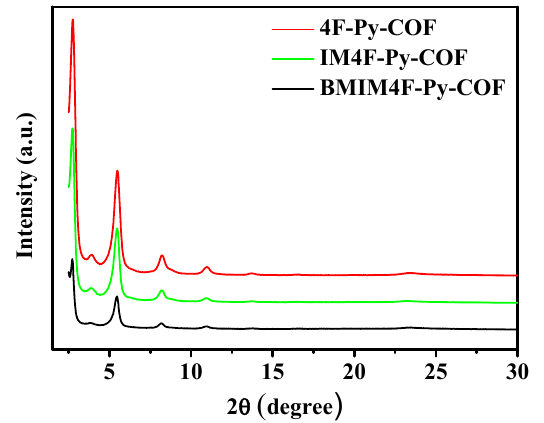
Figure 2. Comparison of PXRD patterns of IM4F-Py-COF (green), BMIM4F-Py-COF (black), and 4F-Py-COF (red).